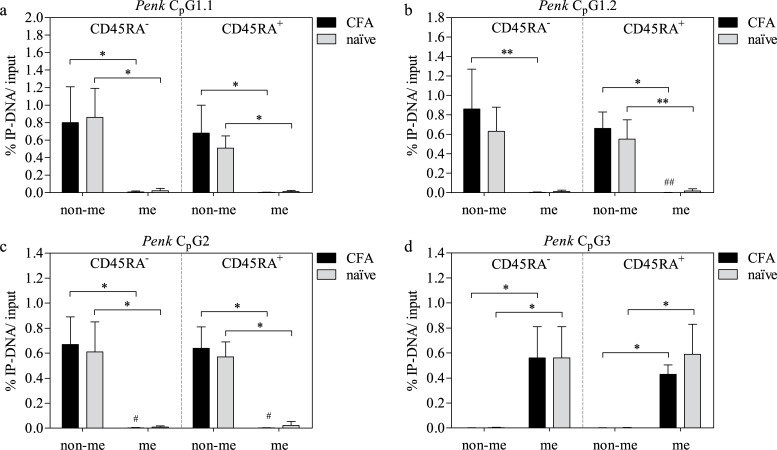
Methylation status of Penk CpG islands in CD45RA± LN cells of naïve and CFA-treated rats.For Penk CpG1 two amplification regions 1.1 (a) and 1.2 (b) were selected, and one region each for Penk CpG2 (c) and Penk CpG3 (d) were chosen for qRT-PCR. Means ± SD; */# P < 0.05; **/## P < 0.01; Friedman test with Dunn’s multiple comparison post hoc test (* non-me vs. me) and MWU test (# CFA vs. naïve); n = 7 (a, c, d, b naïve) and n = 8 (b CFA).